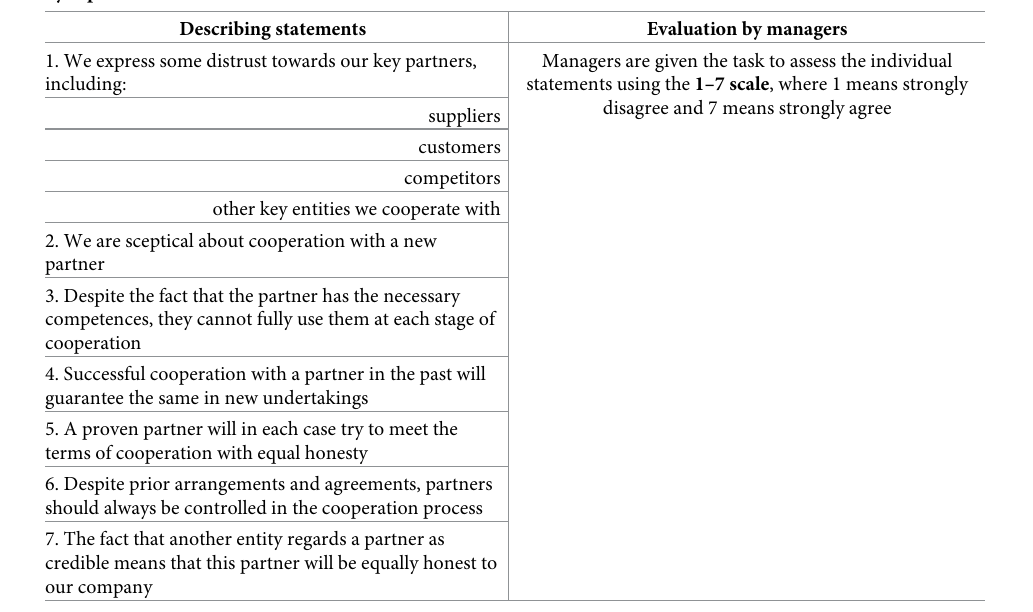
Table 5. Operationalisation of distrust towards partners in relationship construct—after modification proposed by